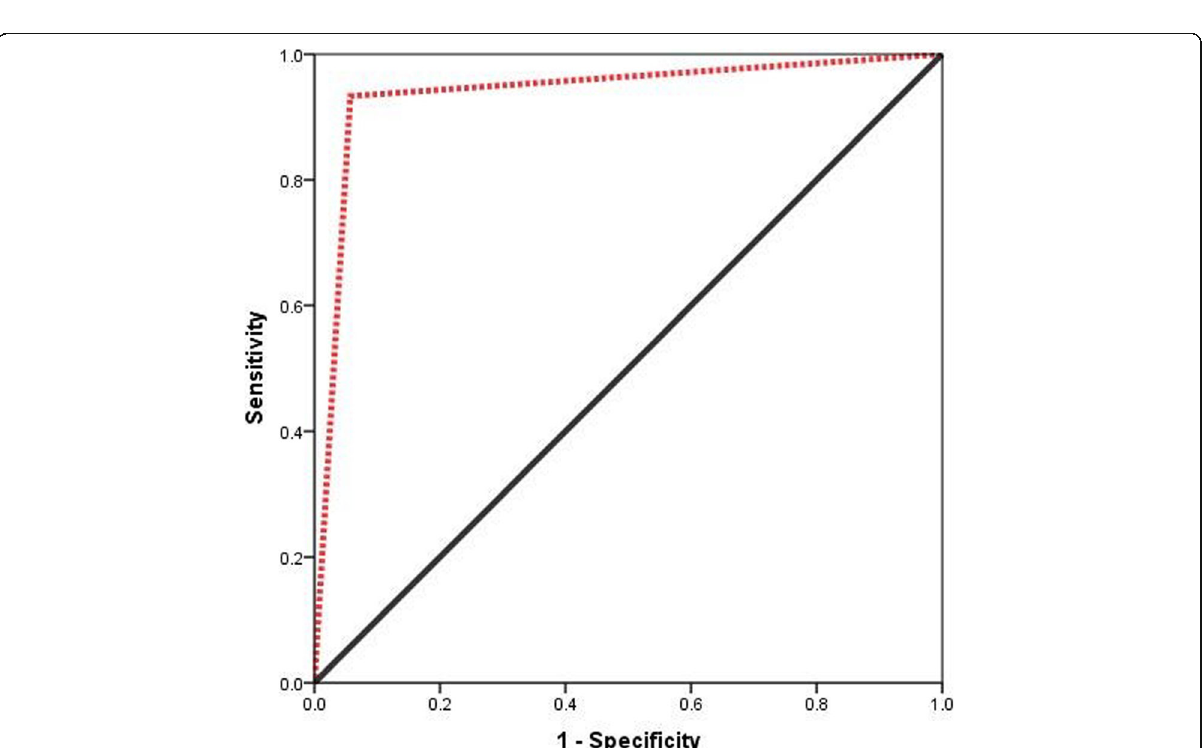
Fig. 3 ROC curve for malignancy prediction via the combined protocol of DCE-MRI and